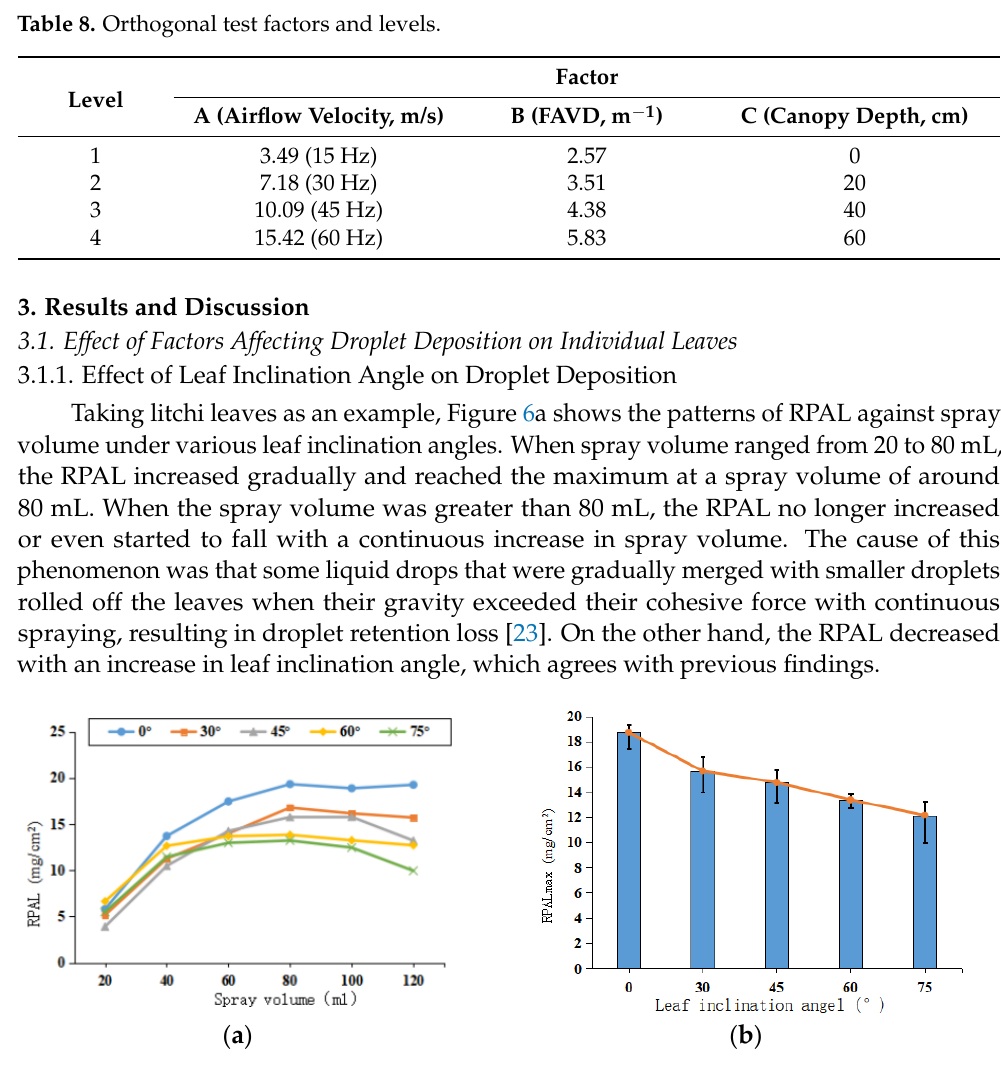
Figure 6. ( a ) Patterns of RPAL against spray volume under various leaf inclination angles; ( b ) maximum RPAL against leaf inclination angle.